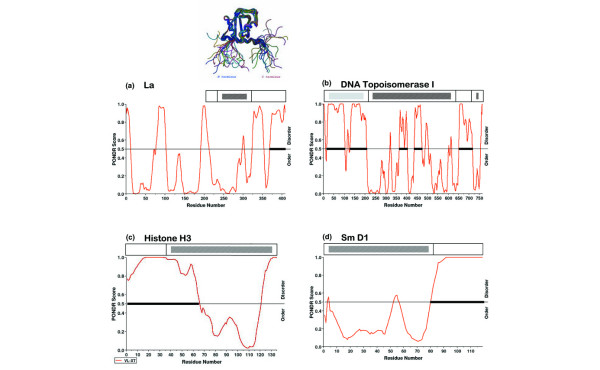
PONDR® predictions compared to experimental structural determinations for various autoantigens. (a) La autoantigen (Swiss-Prot: P05455). The shaded box above the plot (residues 231–325) is the region that Jacks et al. [64] determined to be ordered via NMR. The empty boxes (residues 214–230 and residues 326–408) are regions determined to be unstructured or disordered. The inset (PDB: 1OWX; La222-334) shows the conformational flexibility of disordered regions at the amino and carboxyl terminii of the La fragment. (b) DNA topoisomerase I (Swiss-Prot: P11387). The structure was determined by X-ray methods for a protein-DNA complex (PDB: 1EJ9) encompassing residues 203–765 of DNA topoisomerase I. Residues 634–713 (empty box) are missing and, therefore, disordered in the structure [65]. The lightly shaded box at the amino terminus is the region that was determined to be disordered in the references cited above. (c) Histone H3 (Swiss-Prot: P68431). The structure of chicken H3 in a histone octamer complex (PDB: 2HIO) was determined by X-ray methods for residues 1–135. Residues 1–42 are missing, presumably due to disorder [66]. (d) Sm D1 (Swiss-Prot: P62314). The structure of a protein complex between Sm D1 (residues 2–119) and Sm D2 was studied by X-ray methods (PDB: 1B34) [67]. Residues 82–119 from Sm D1 are missing from the structure.